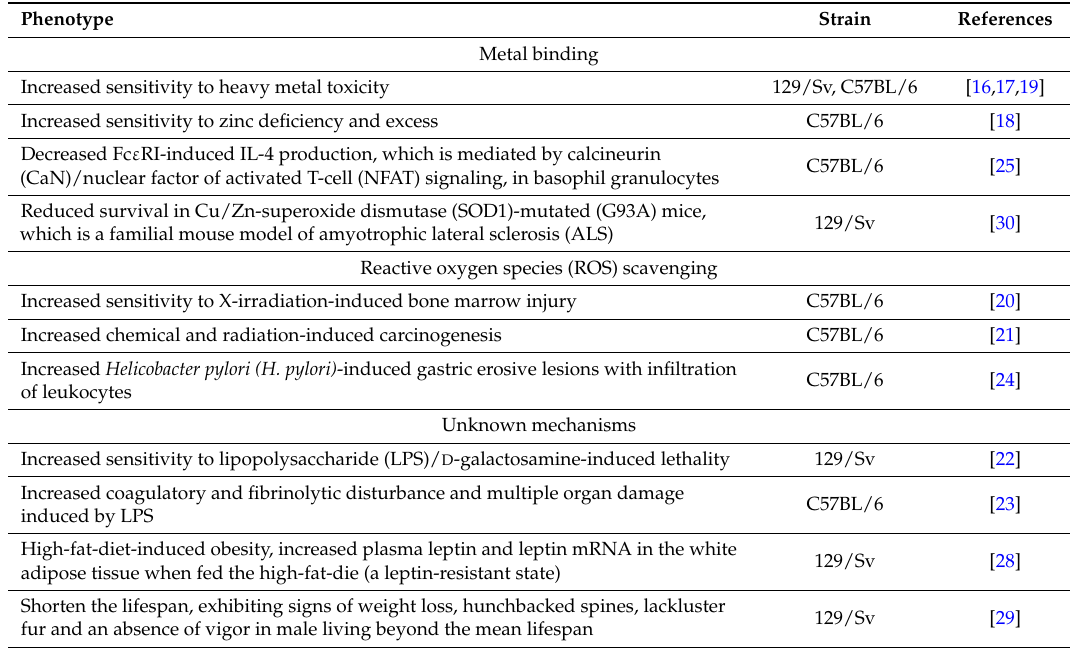
Table 1. Knockout (KO) phenotypes of MT1/2